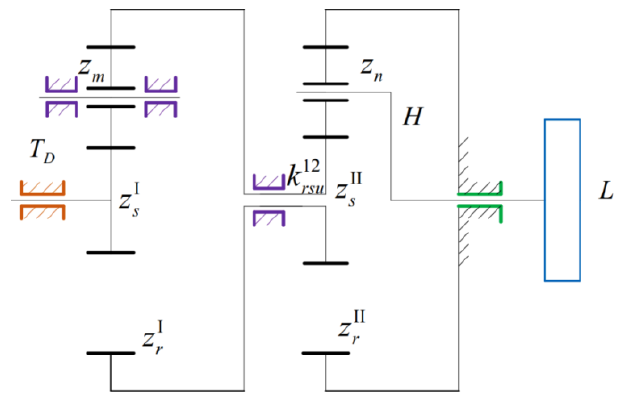
Figure 2. Transmission diagram of a planetary composite system with a two-level power branch.